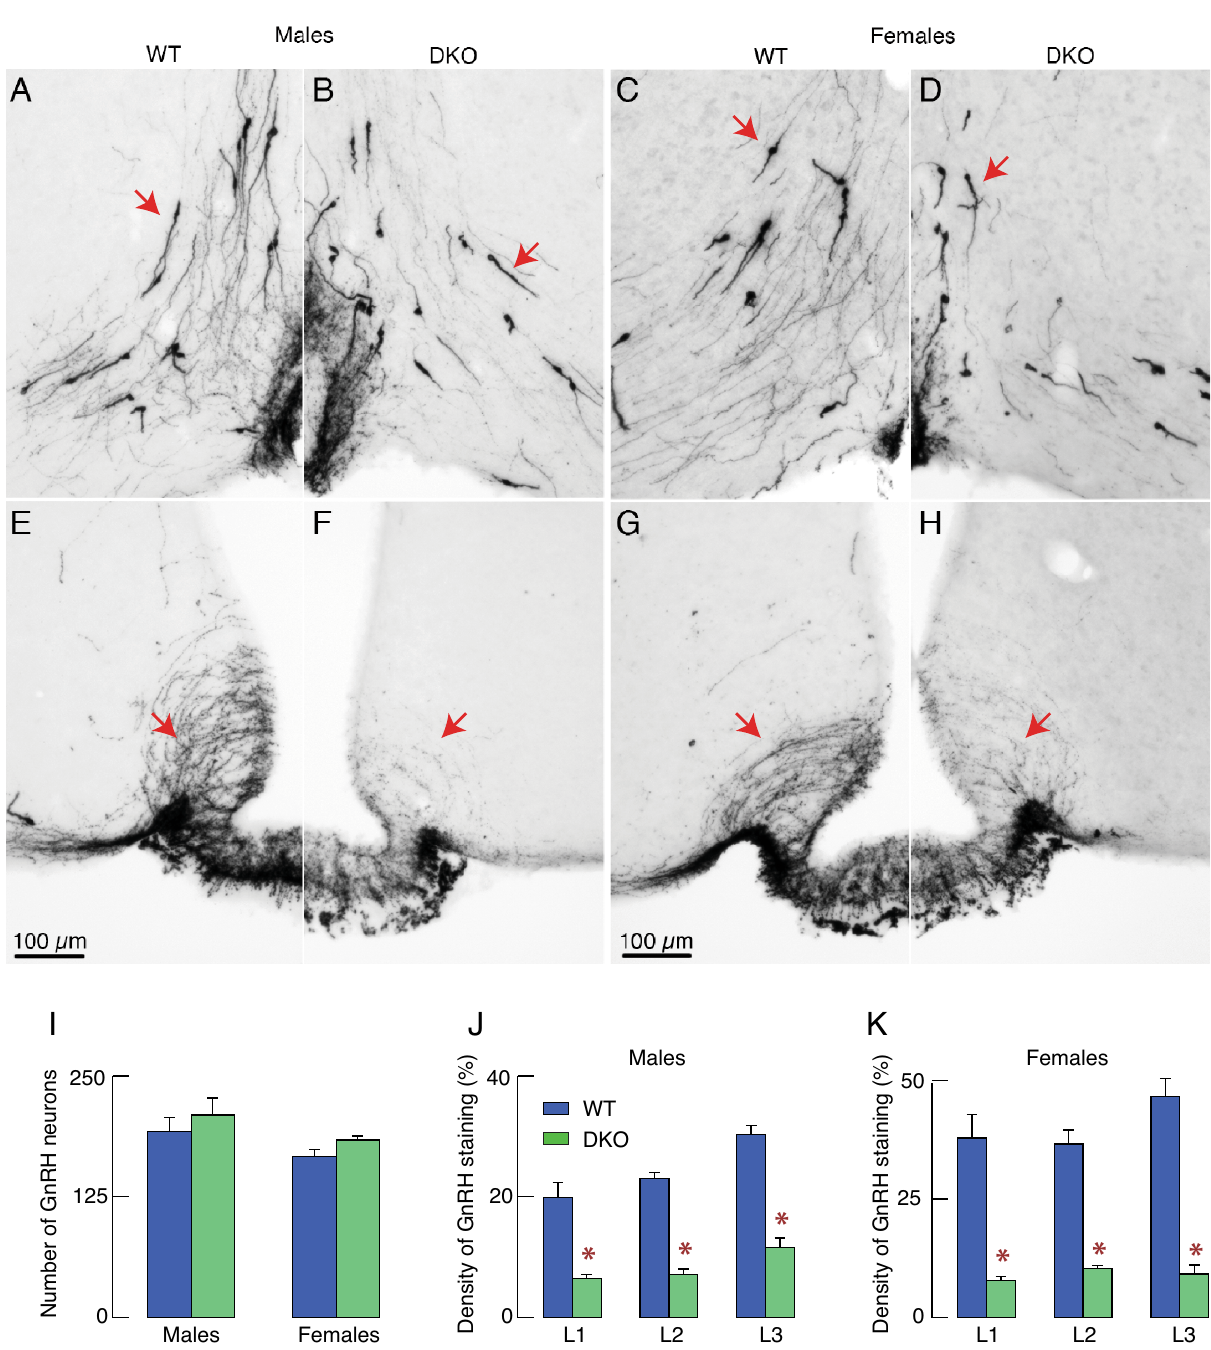
Figure 7. Effects of DKO on the distribution and functions of GnRH-secreting hypothalamic neurons. ( A – D ) GnRH cell body distribution in the hypothalamus. Red arrows, representative examples of GnRH cell bodies. Pattern of immunopositive GnRH neuron expression in WT (A) and DKO males (B) and WT (C) and DKO females (D). (E – H ) GnRH fibers through the arcuate nuclei; red arrows, representative examples. GnRH immunoreactivity in WT (E) and DKO males (F) and WT (G) and DKO females (H). Horizontal bars of 100 µm also apply to all panels. ( I – K ) Quantification of the effect of DKO on the hypothalamic GnRH- secreting neurons. ( I ) Number of GnRH neurons per brain series (i.e. 25% of the brain). ( J , K ) Density of GnRH staining through the arcuate nucleus of males (J) and females (K). L1–L3, different levels of the arcuate nuclei, as described in Material and Methods. Data shown are mean ± SEM from six measurements per region; asterisks, P < 0.01 between